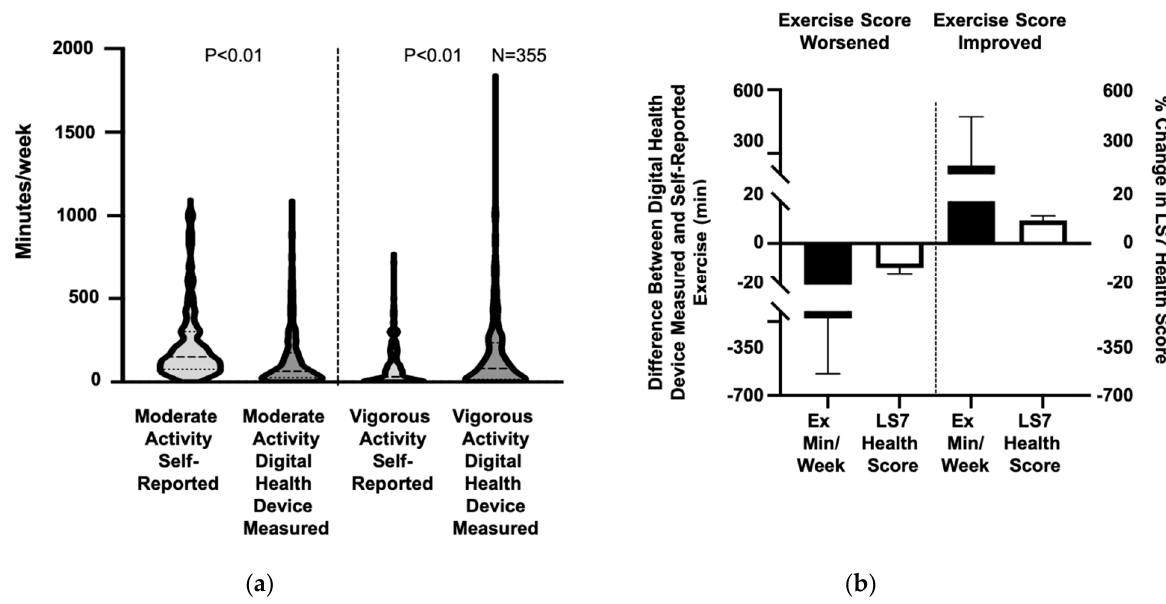
Figure 3. Self-reported exercise activity compared to digital-health-device-measured exercise activity. ( a ) Participant self-reported moderate and vigorous exercise minutes/week were compared with digital-device exercise moderate and vigorous exercise minutes per week and summarized graphically in violin plots. Median and quartiles are denoted by dashed lines, n = 355. ( b ) Digital-device-measured exercise (Ex) minutes (Min) per week were calculated. There are both increases and decreases in exercise minutes identified by digital health devices within the study population. The effect of a large difference in measured versus reported exercise, change in Activity Score, and change in Life’s Simple 7 Health Score is illustrated. In 74 participants, digital-device-measured exercise is less than reported exercise minutes and Activity Score and Health Score decreased. In 54 participants, the measured exercise minutes are higher than reported and the Activity Score and Health Score increased. LS7, Life’s Simple 7.